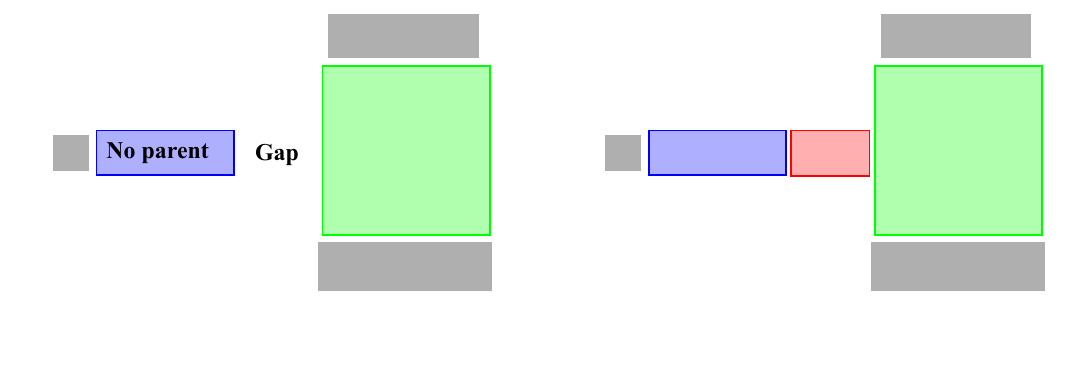
Figure 12. Filling gaps. The blue cylinder ( A ) has no parent, but there is a nearby green cylinder C with a larger radius. The gap between these two cylinders is filled by the red cylinder ( B